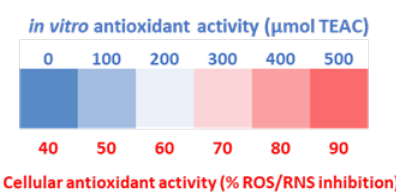
Figure 7. In vitro cell-free antioxidant (FRAP, CUPRAC, ABTS, DPPH and ORAC) and cellular antioxidant assay of extracts (CAA) from 25 different populations of M. angustifolia and 6 different populations of M. hastata . TEAC: TroloxC equivalent antioxidant capacity; ABTS: 2,2-azinobis (3-ethylbenzthiazoline-6-sulphonic acid); DPPH: 2,2-diphenyl-1-picrylhydrazyl; FRAP: ferric reducing antioxidant power; CUPRAC: cupric reducing antioxidant capacity; ORAC: oxygen radical absorbance capacity; CAA: cellular antioxidant assay. Means and standard deviations are provided in Table S2.